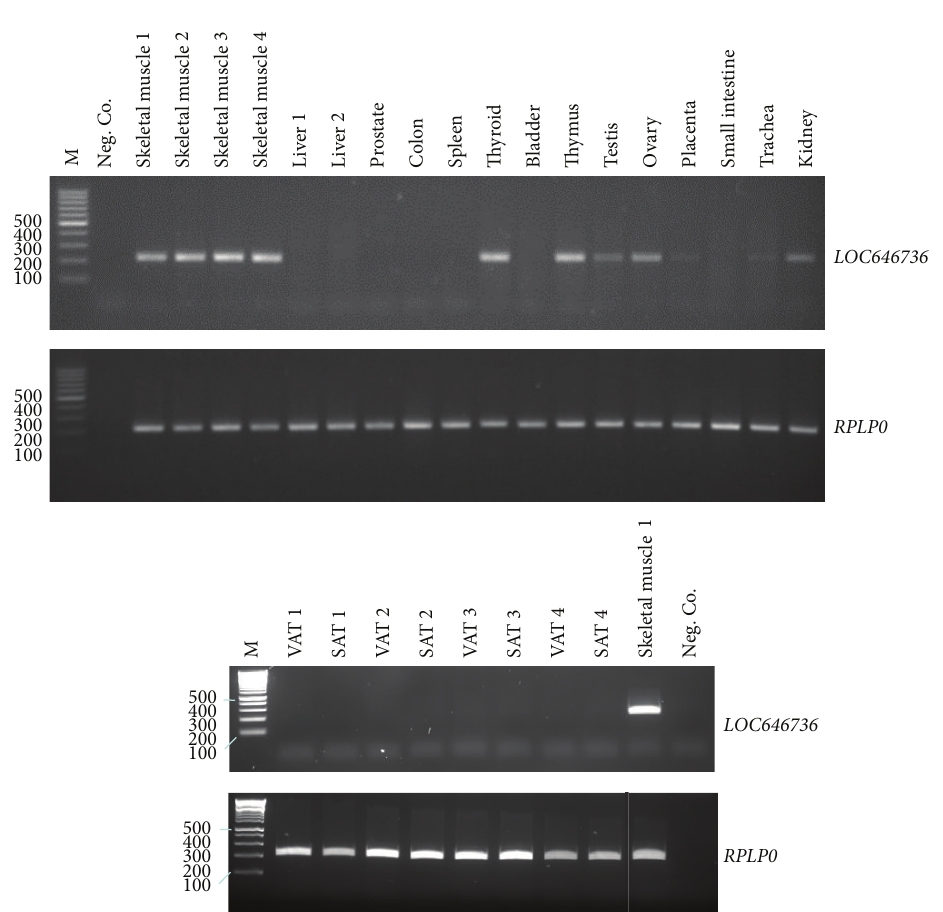
of the more common allele [1.13 (0.43) versus 0.95 (0.29), 𝑃 = 0.059 ]. Furthermore, subjects homozygous for the more common allele of rs2713538 displayed nominal higher expected mean log-transformed IRS1 transcript levels in